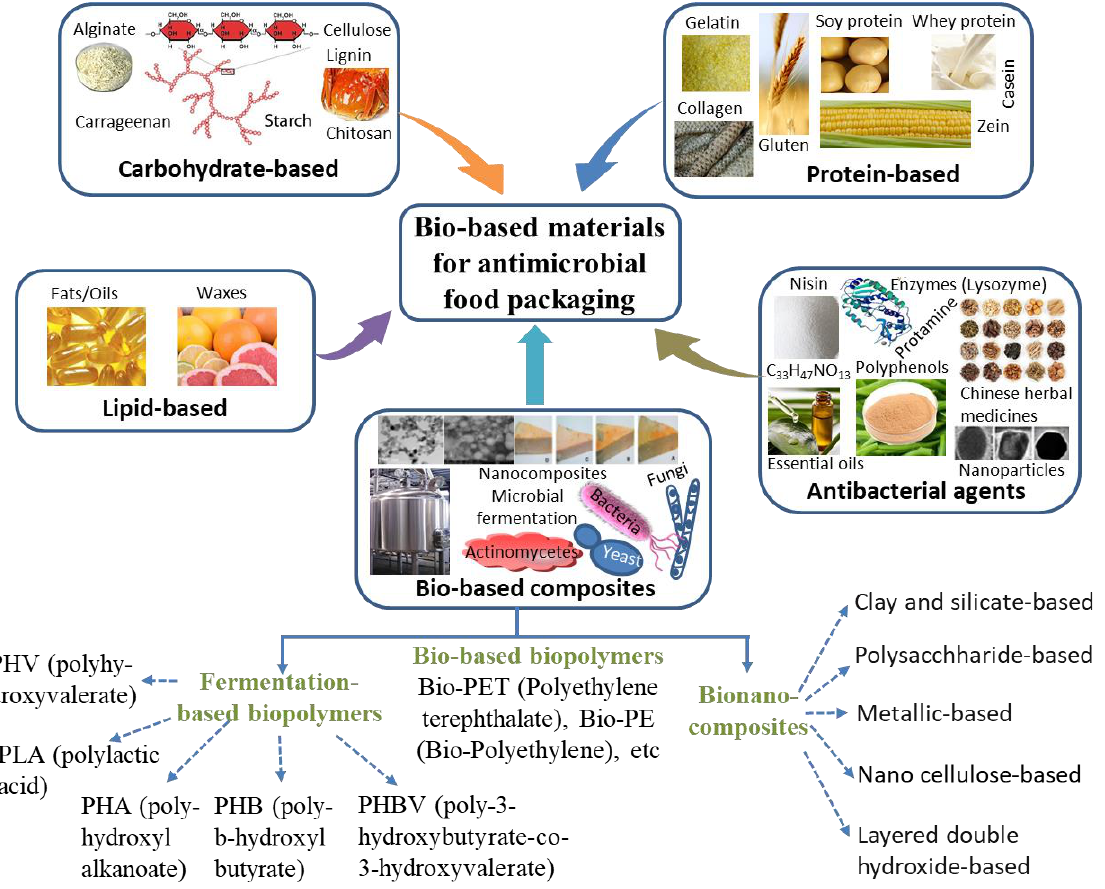
Figure 2. Types of bio-based materials used for antimicrobial food packaging application.